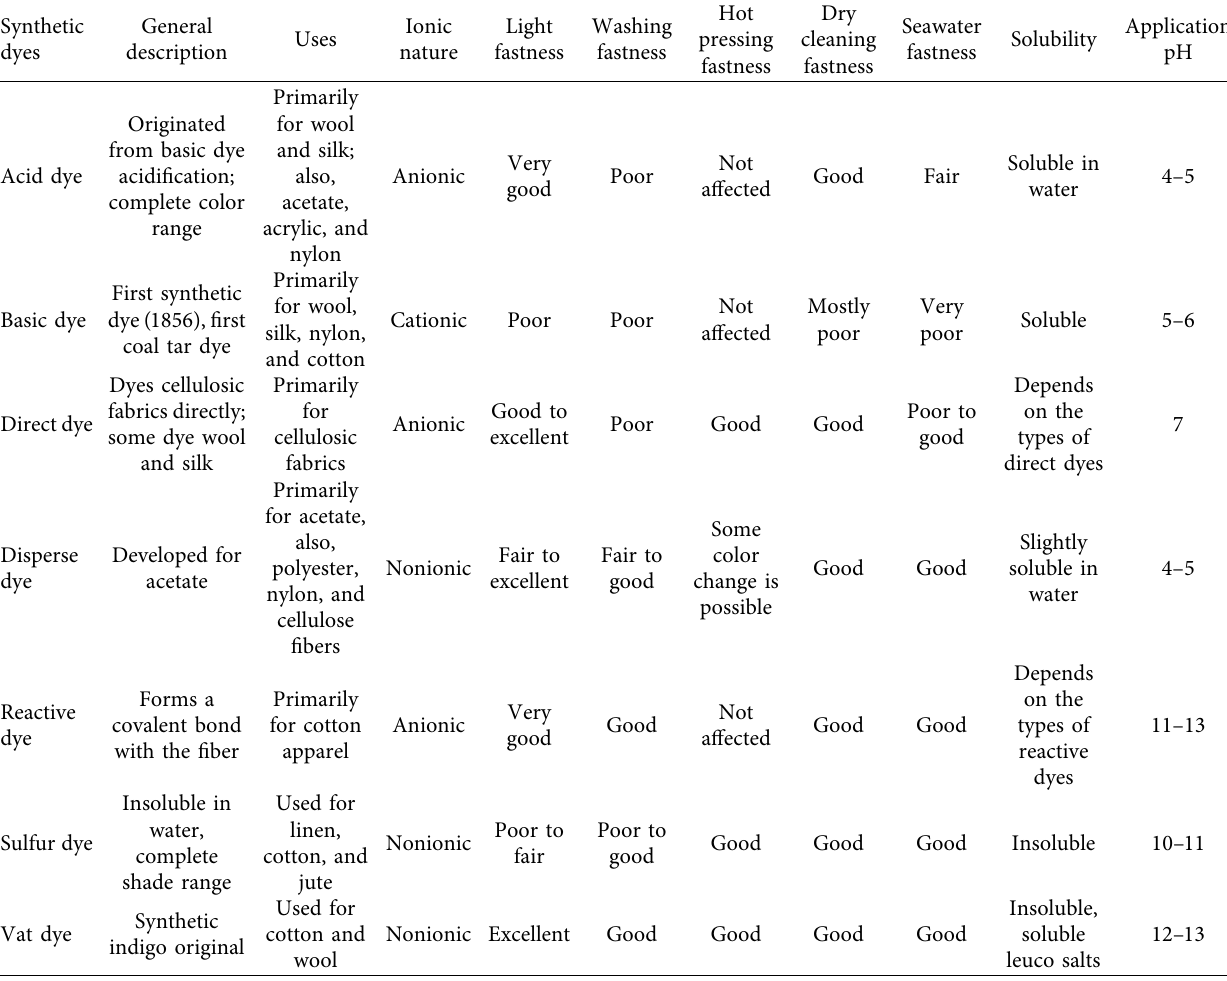
Table 1: Characteristics of synthetic dyes [9, 15,